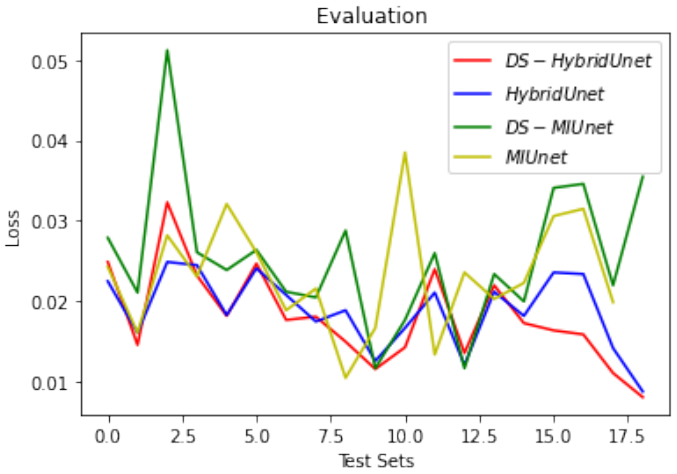
Figure 25. Comparison of Evaluation Loss.